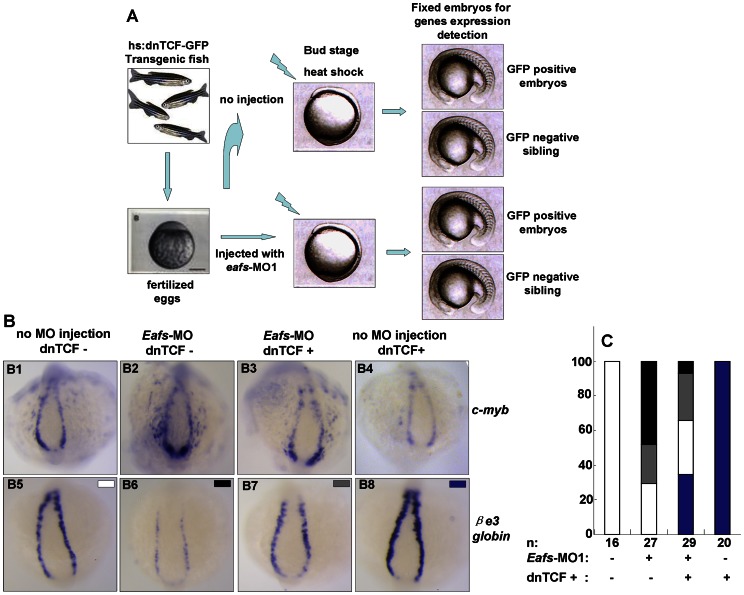
Knockdown Wnt signaling in eafs morphants by transiently inducing dn-Tcf expression rescued defects of c-myb expression and erythroid cells specification.(A) Scheme of rescuing experiments in eafs morphants by using hs:dnTCF-GFP embryos. (B) Increased c-myb expression and reduced βe3 globin expression were restored in eafs morphants by transiently inducing dn-Tcf in embryos at the bud stage. B1–B8, dorsal view, anterior to the up.